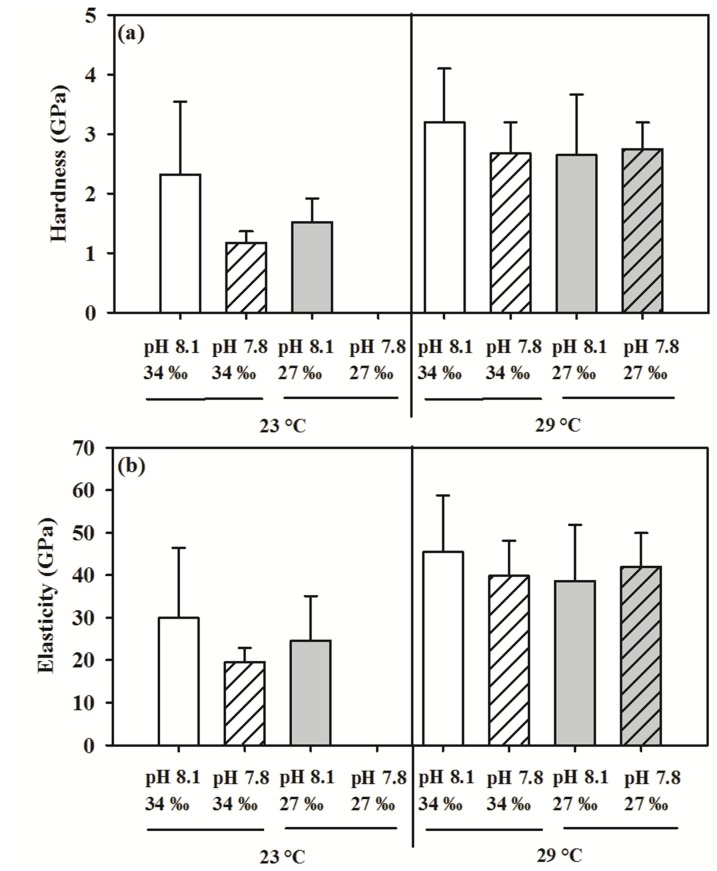
Effects of pH, salinity and temperature on mechanical properties of the tubes built by Hydroides elegans, (a) hardness and (b) elasticity.Each bar represents the mean ± SD of four replicates, except control had four replicates.